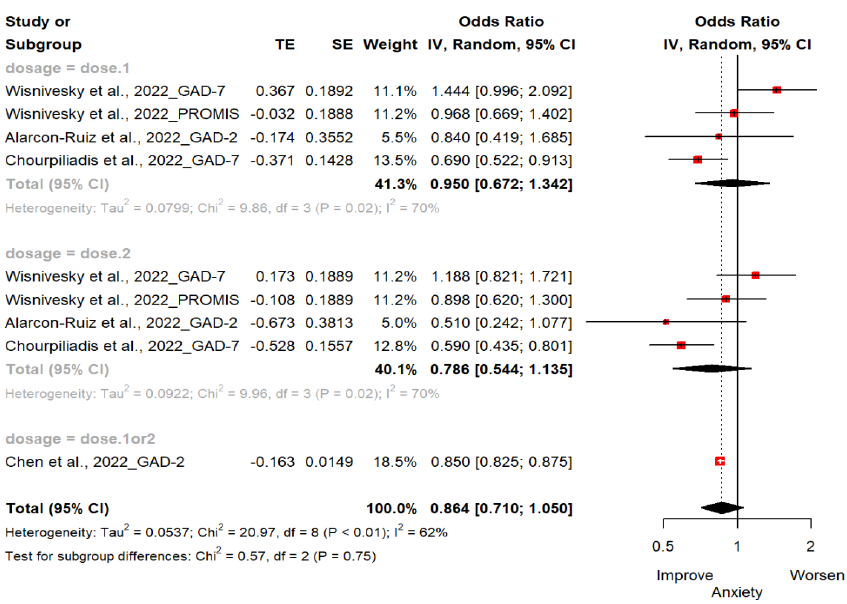
Figure 3. Forest plot diagram showing the effect of COVID-19 vaccination on anxiety. Odds ratio; CI, confidence interval. [18–21]